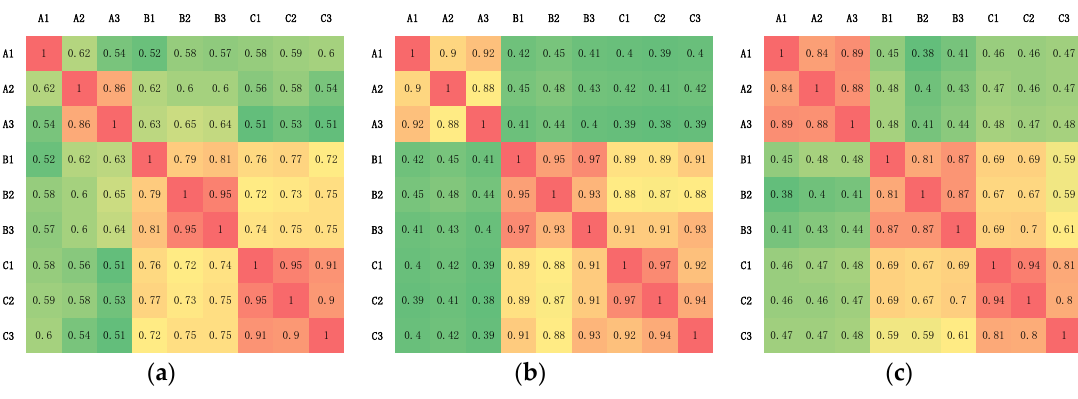
Figure 12. Shape similarity results of three different lakes: ( a ) shape similarity matrix by Zernike moments, ( b ) shape similarity matrix by Fourier descriptors of convex hull; and ( c ) shape similarity matrix by our method.